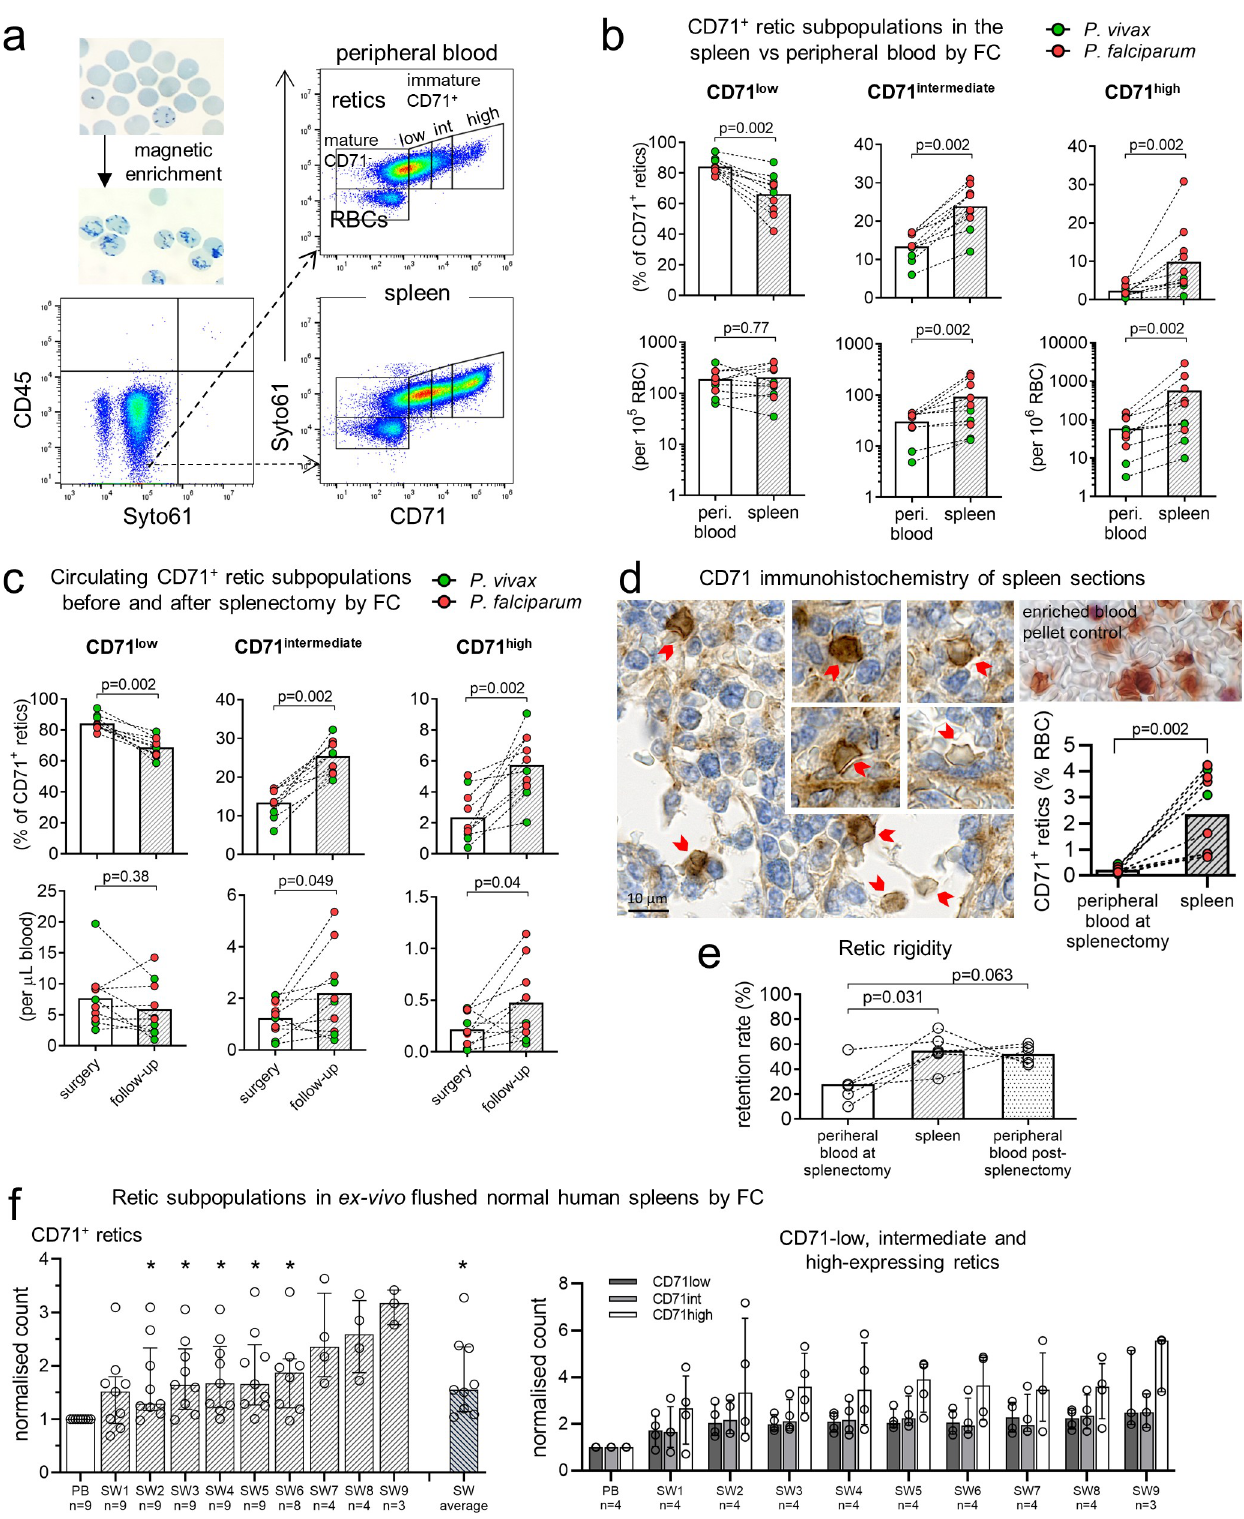
Fig 4. Increased density of immature CD71 + reticulocytes in human spleens. Samples were magnetically enriched for reticulocytes (retics) and phenotyped by CD71 FC (a). The median retic purity in enriched samples was 95.8% [IQR: 94.3%–98.5%] for PB and 56.8% [IQR: 53.4%–72.6%] for sliced- spleen blood. Numbers as a percentage of CD71 + retics and per 10 5 or 10 6 RBCs were determined for CD71 low-, intermediate- and high-expressing retics